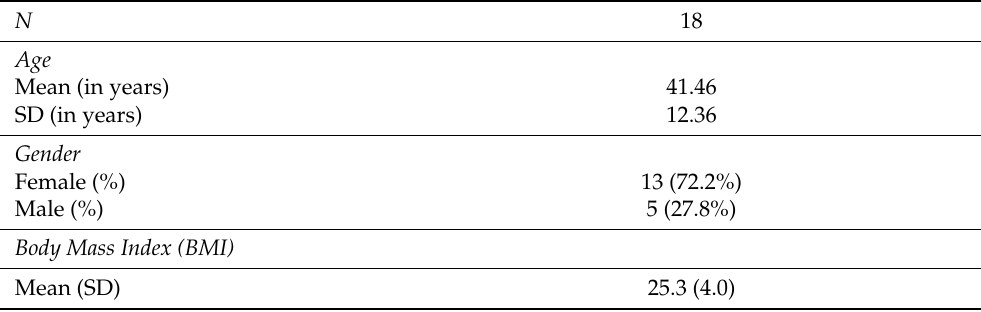
Table 1. The demographic characteristics of the enrolled participants.